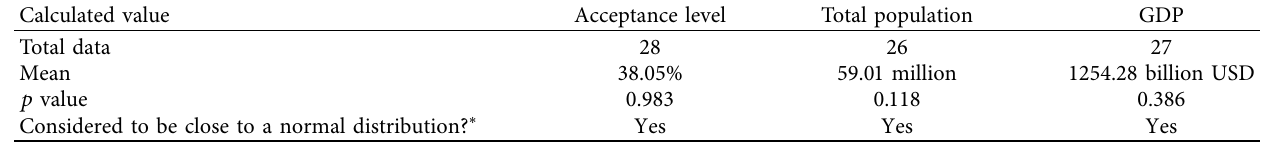
Table 5: Te calculation results of the normality test for data on acceptance levels, total population, and GDP.